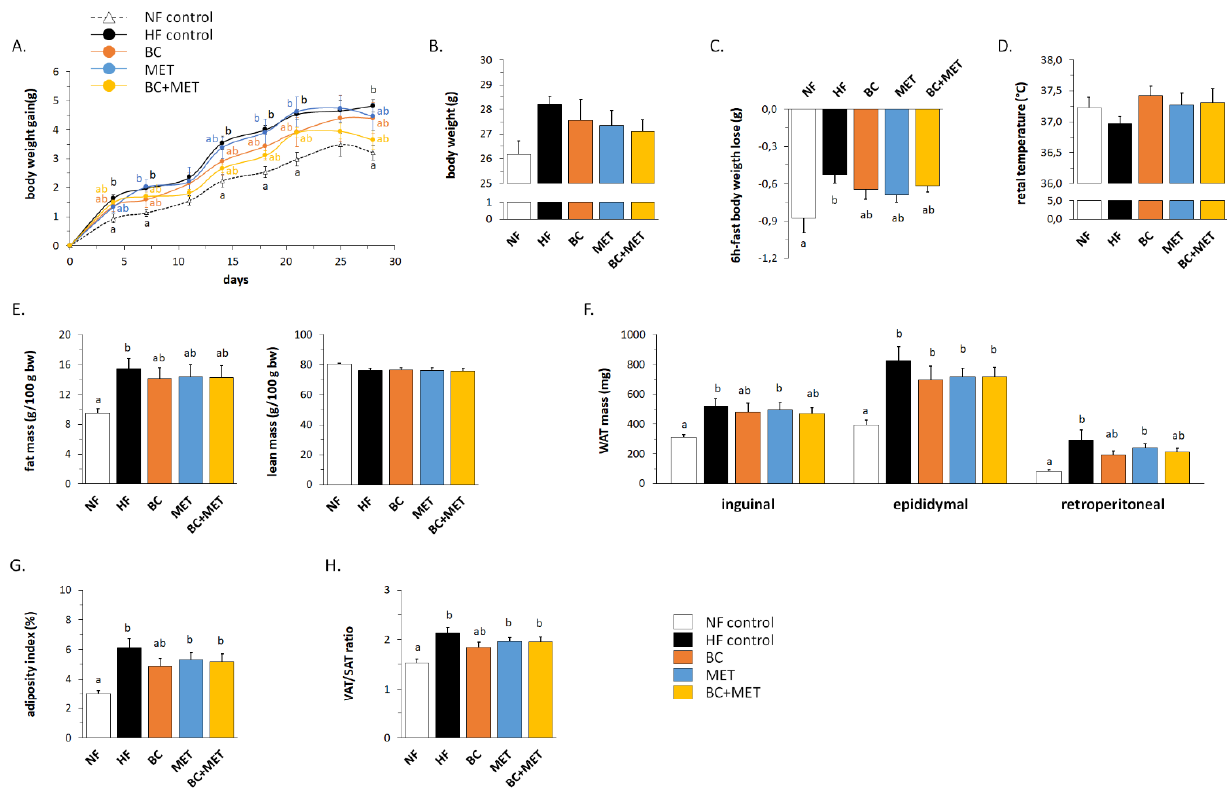
Figure 1. Evolution of body weight (bw) gain during the dietary challenge ( A ), body weight at the end of experiment ( B ), body weight lost upon a 6 h-fast ( C ), rectal temperature ( D ) and body composition ( E ) 5 to 7 days prior the sacrifice. Inguinal, epididymal and retroperitoneal white adipose tissue (iWAT, eWAT and rWAT) weights ( F ), adiposity index as the sum of WAT weights as percent body weight ( G ) and the visceral (VAT: eWAT and rWAT) to subcutaneous (SAT: iWAT) ratio ( H ) at the end of the experiment. Obesity-prone mice were challenged with a high-fat diet for 4 weeks while receiving placebo (HF control) or being treated orally with BC (3 mg/kg/day), MET (100 mg/kg/day), or their combination (BC+MET); a fifth group received placebo and was kept on a normal-fat diet (NF control). Data are means ± SEM of seven to nine animals per group. To compare between groups, one- way ANOVA followed by Tukey’s Honest Significant Dif- ference post hoc test was used: bars not sharing a common letter (a and b) are significantly different (a ≠ b) ( p < 0.05). Microscopical examination and morphometric analysis of the inguinal fat depot (iWAT) revealed a significant increase in mean adipocyte area following HFD feeding in the HF, BC and MET groups, but not in the BC+MET group (Figure 2A,B). Detailed anal- ysis revealed a decrease in the percentage of small adipocytes and an increase in the per- centage of large adipocytes in the HF group as compared to the NF group (Figure 2C), thus reflecting HFD-induced adipocyte hypertrophy. Similar HFD-induced changes were observed in the BC mice and the MET mice, whose iWAT adipocyte size distribution was similar to that of HF mice (Figure 2D). In contrast, compared with the HF control mice, BC+MET mice had after HFD an increased percentage of small adipocytes and a decreased percentage of large adipocytes in iWAT (Figure 2D), suggesting increased hyperplasic and decreased hypertrophic tissue expansion in the BC+MET mice. No signs of WAT brown- ing — such as the emergence of brown-like adipose cells with a multilocular intracellular lipid distribution — were noticed in any of the experimental groups.